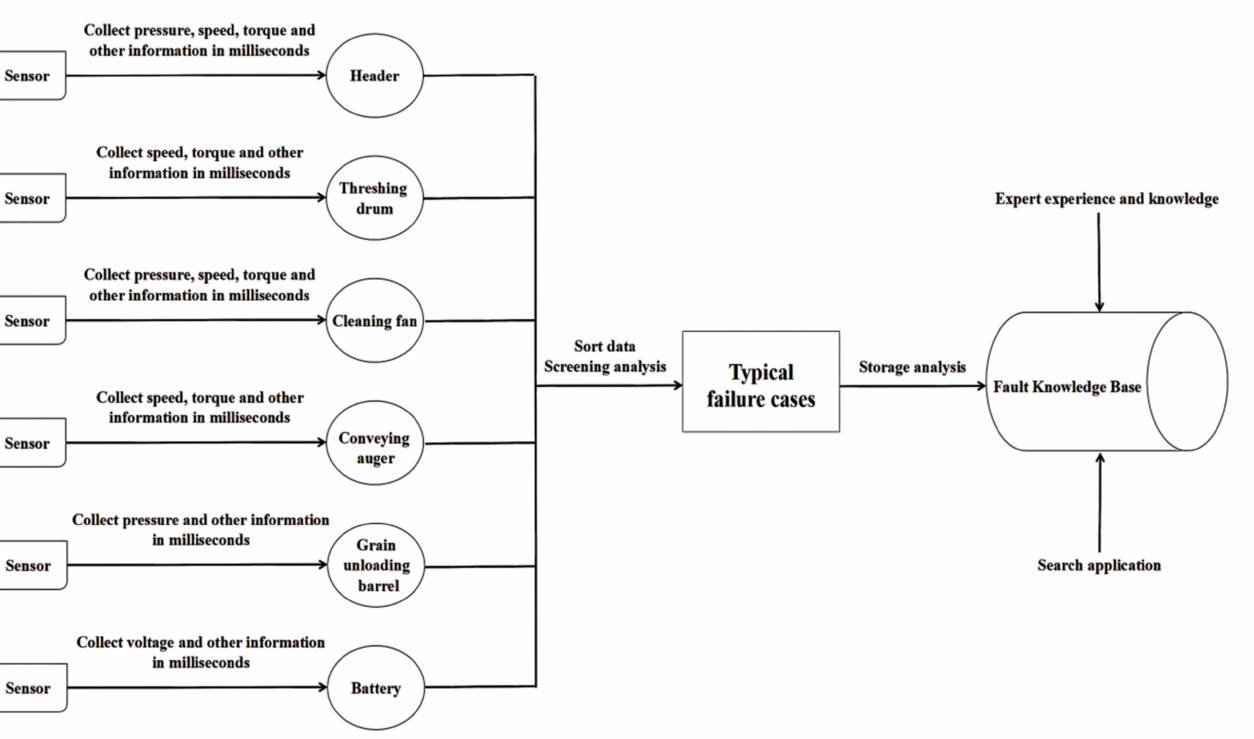
Figure 6. Fault diagnosis flow